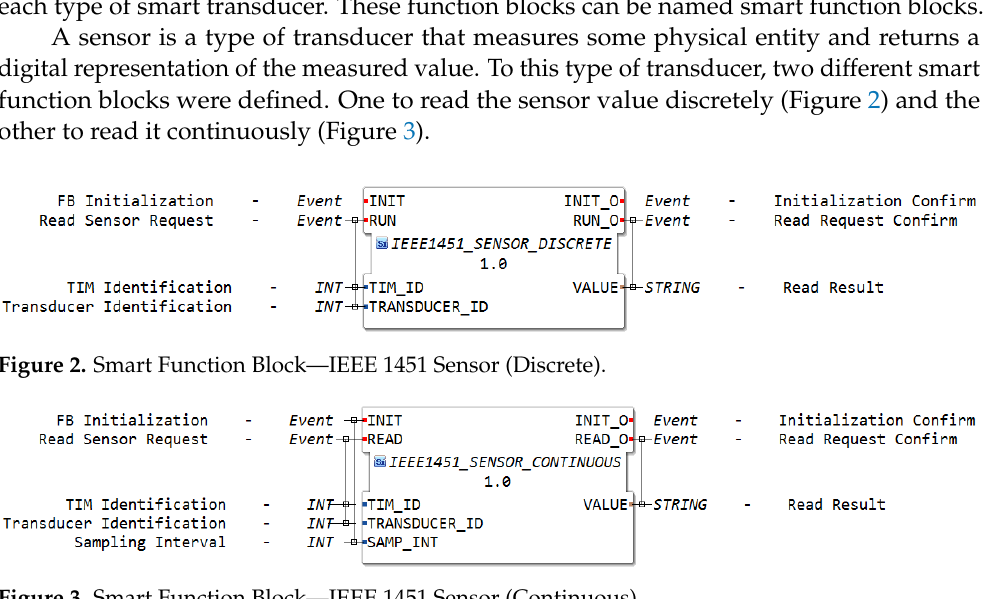
Figure 3. Smart Function Block—IEEE 1451 Sensor (Continuous).